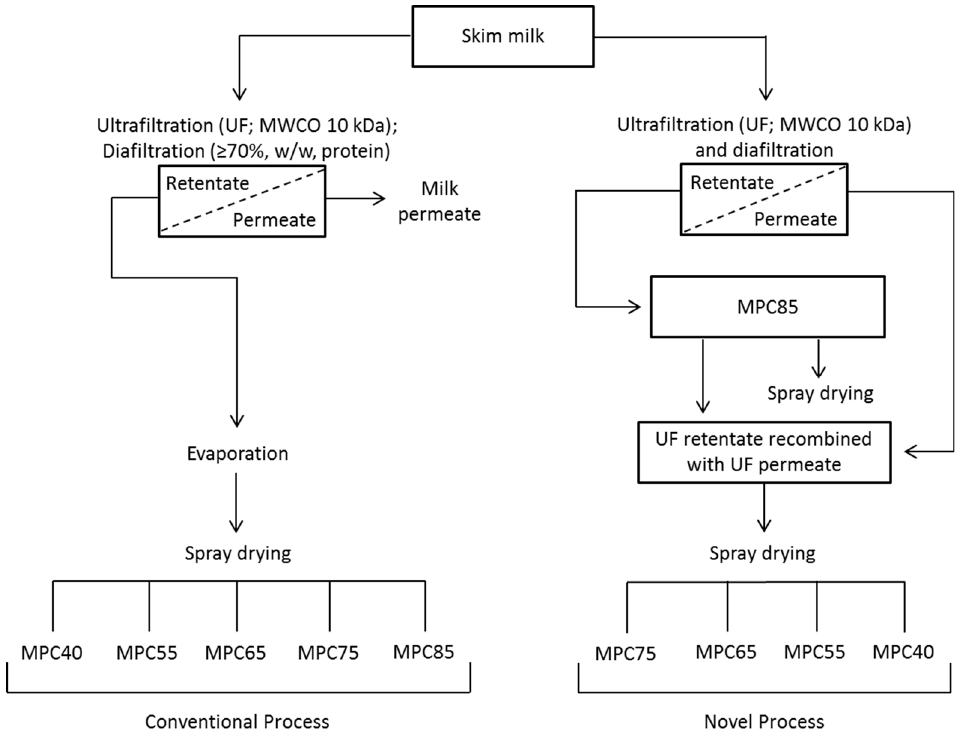
Figure 1. Process flow diagram of conventional and novel approaches for the production of milk protein concentrate (MPC) powders. Table 1. Composition of milk protein concentrate (MPC) powders.